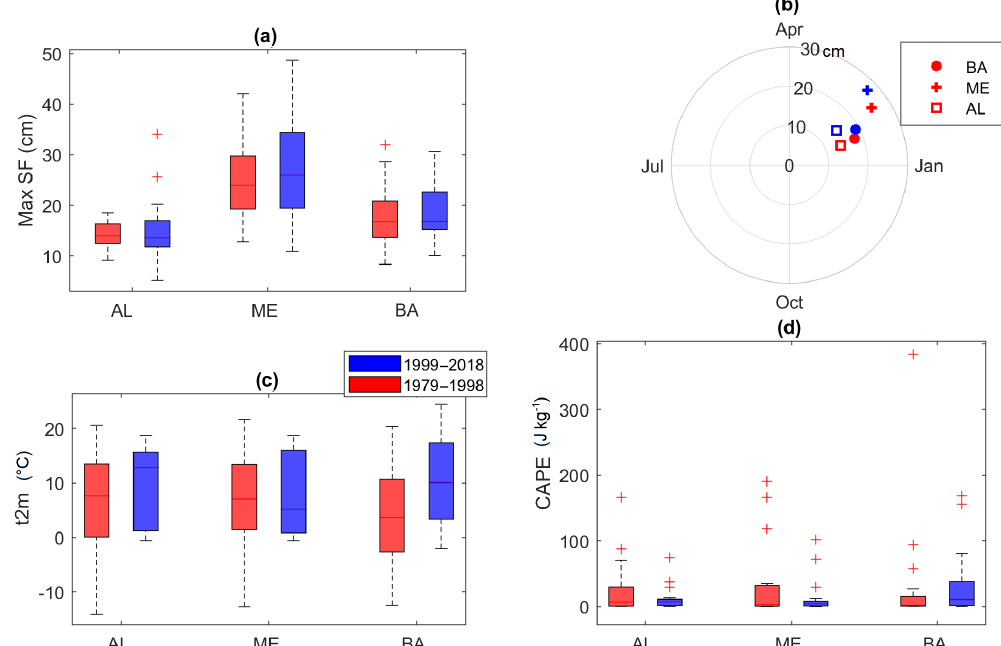
Figure 6. (a) Box plots of the maxima yearly SF for two periods: 1979–1998 (red) and 1999–2018 (blue). (b) Seasonal analysis for maximum yearly SF. The polar plots show average maxima yearly snowfall for the two periods (different colors). Each symbol corresponds to a different country. The angle corresponds to a date of the year in a counterclockwise sense. Box plot of 2m temperatures (t2m) (c) and CAPE (d) observed during extreme snowfall events. For box plots, on each box, the central mark indicates the median, and the bottom and top edges of the box indicate the 25th and 75th percentiles, respectively. The whiskers extend to the most extreme data points, and the outliers are plotted individually using the “ + ” symbol. Albania (AL), Montenegro (ME), Bosnia